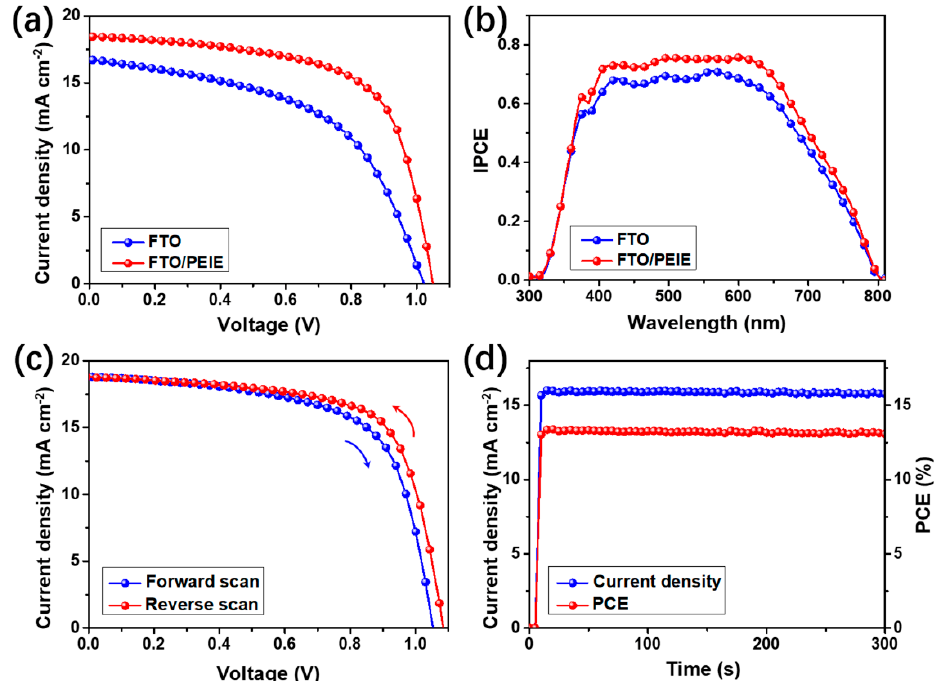
Figure 4. J – V characteristics under forward scan ( a ) and IPCE spectra ( b ) of the PSCs fabricated on bare FTO and FTO/PEIE as the cathodes; ( c ) J – V characteristics of a best performing PSC fabricated on FTO/PEIE under forward and reverse scans; ( d ) current density and PCE as a function of time for the best performing PSC with an applied bias of 0.76 V. Table 1. Solar parameters (extracted from 16 individual devices) of the PSCs fabricated on bare FTO, FTO/PEIE and FTO/TiO 2 .